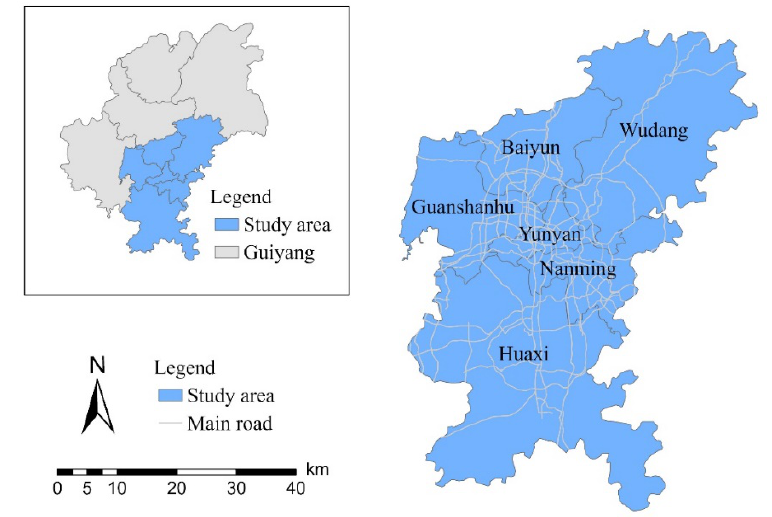
Figure 1. Study Area. Six districts of Guiyang.